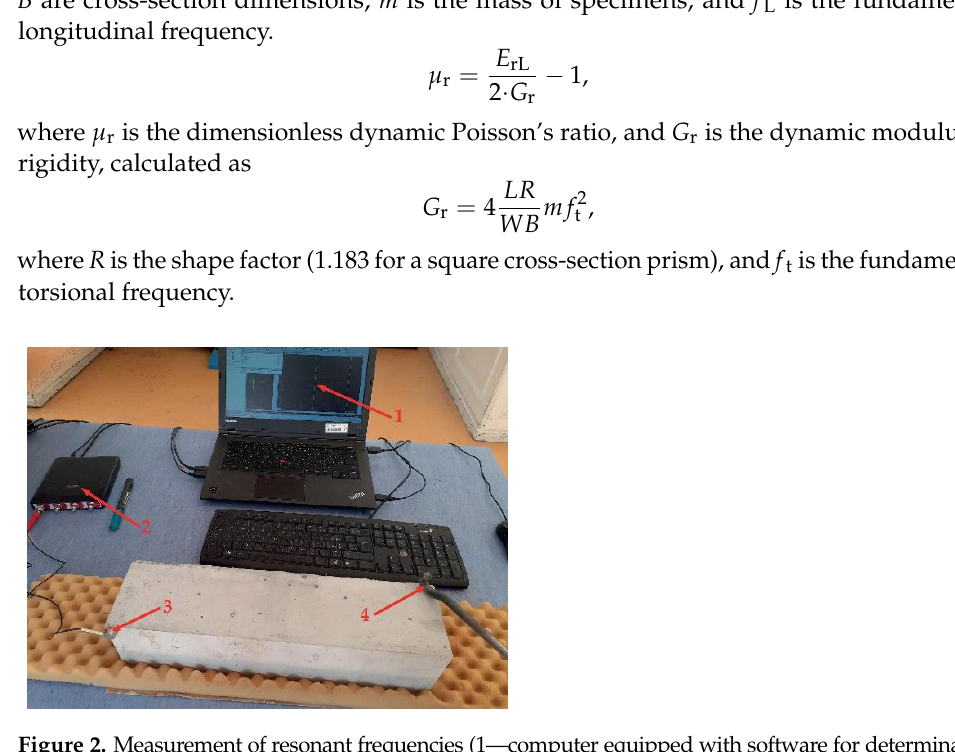
Figure 2. Measurement of resonant frequencies (1—computer equipped with software for determination of resonant frequencies; 2—Handyscope HS4 oscilloscope; 3—acoustic sensor; 4—impact hammer).